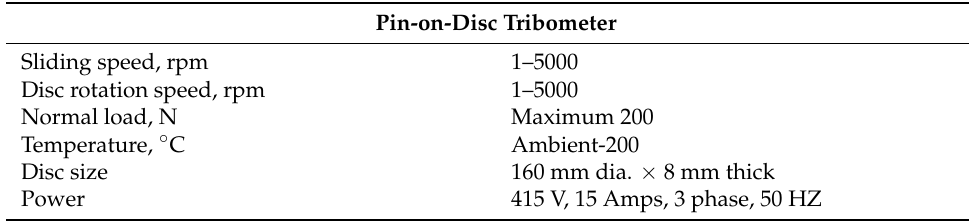
Table 2. Specifications of the pin-on-disc tribometer.